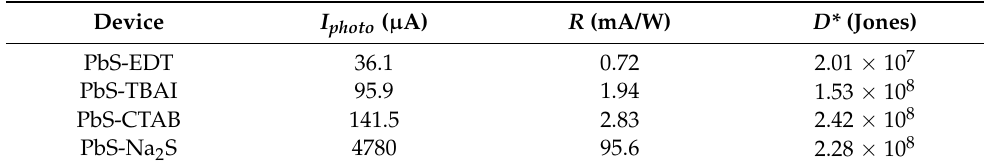
Table 1. Summary of the performance of PbS quantum dot photodevices.